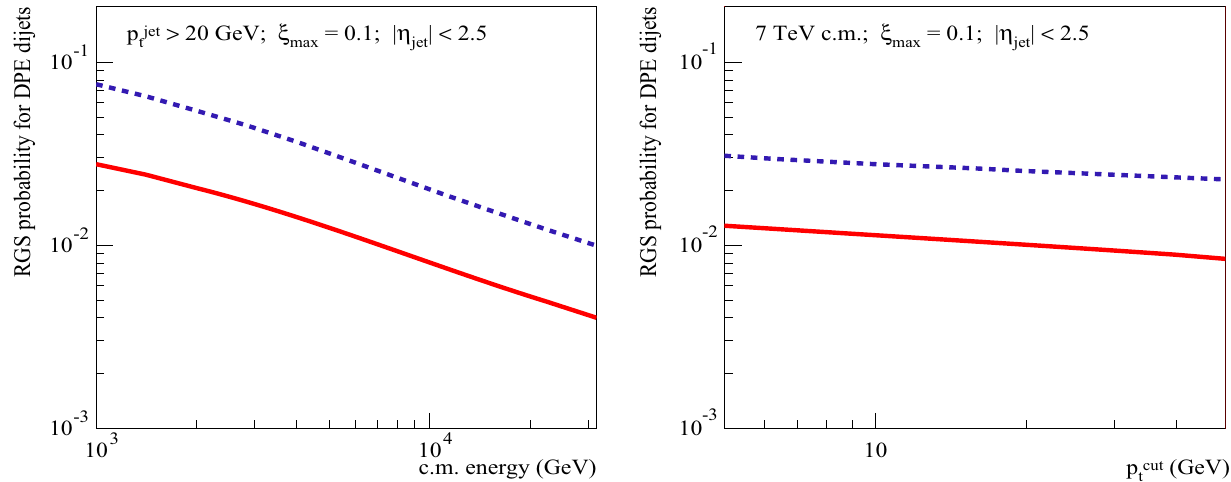
√ s = 7 TeV (right) of the RGS factors S 2 t -dependence for